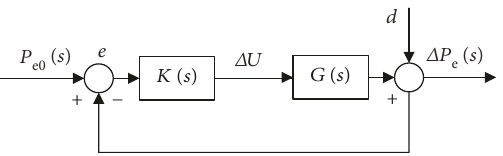
Figure 8: The block diagram of pressure control for the insulation